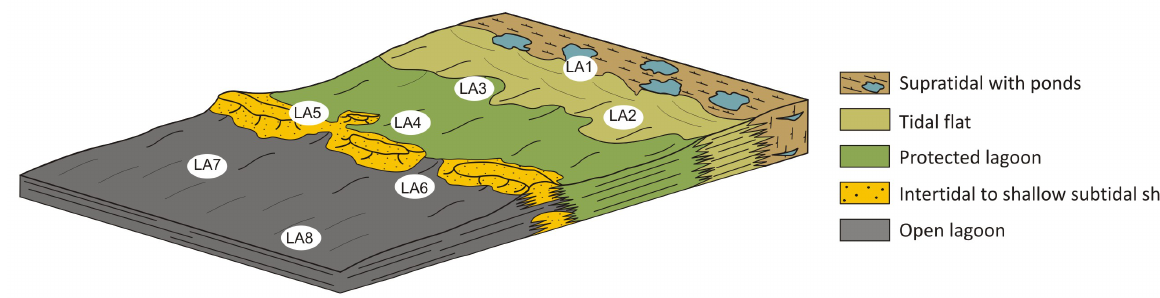
Fig. 3. Schematic depositional model with facies distribution.